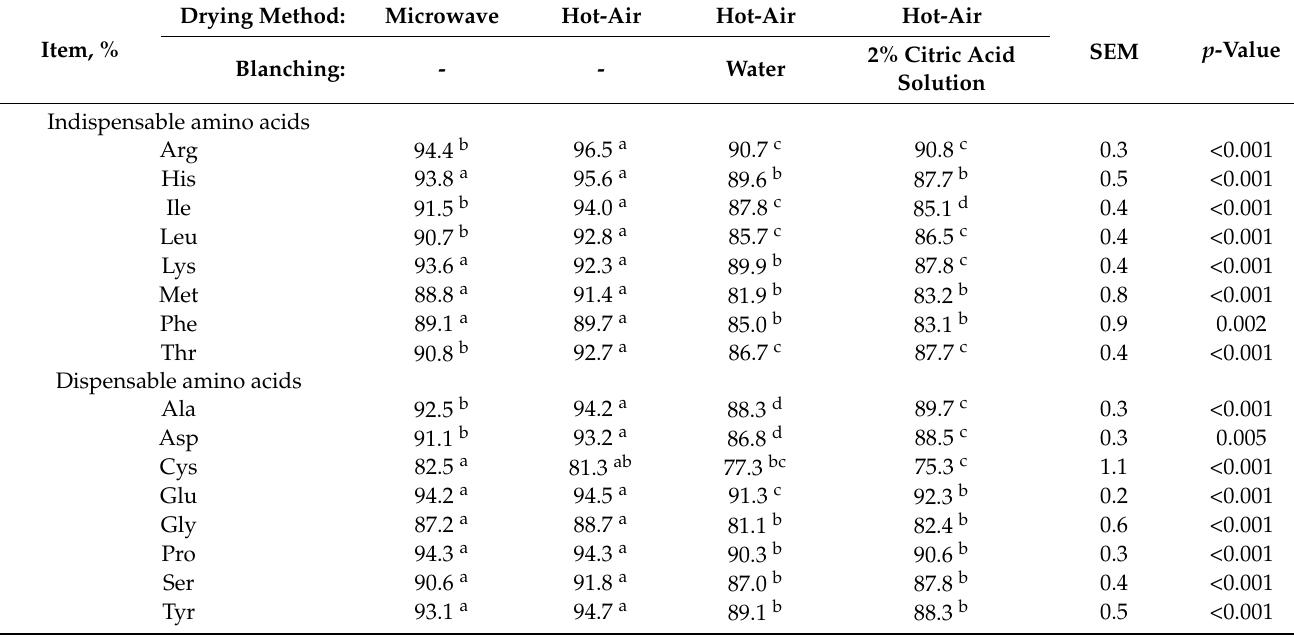
Table 3. In vitro ileal disappearance of amino acids in four black soldier fly larva meals with various drying and blanching methods for pigs 1